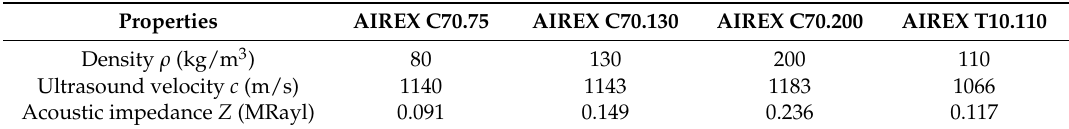
Table 1. Properties of polymers used in matching elements.